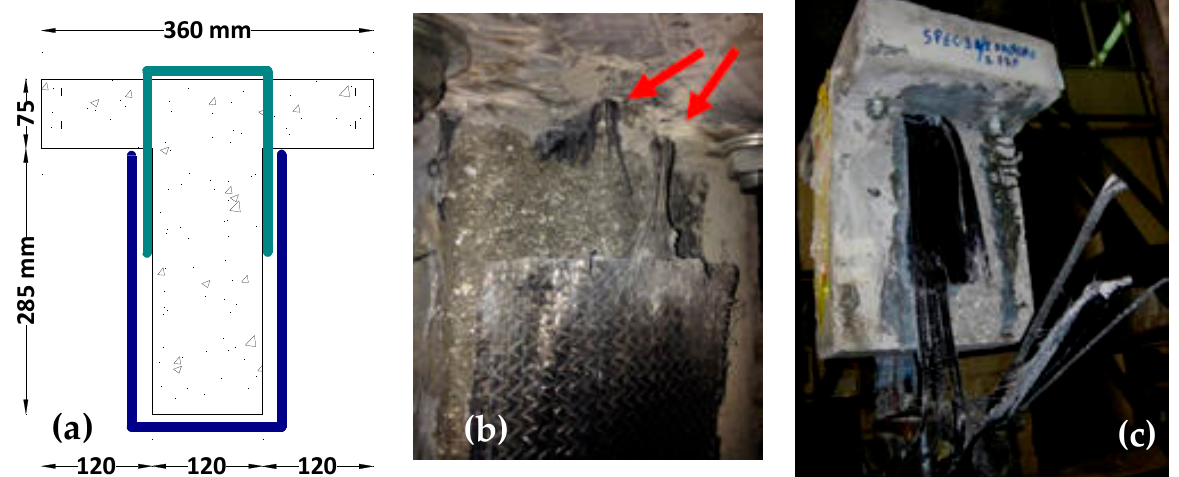
Figure 13. ( a ) R/C T-beam with an attached open hoop FRP strip anchored with an FRP anchor. ( b ) Mode of failure of specimen SW600C/1 No 1. Fracture of the CFRP rope. ( c ) Mode of failure of specimen SW600C/2 No 1. Fracture of the CFRP strip.